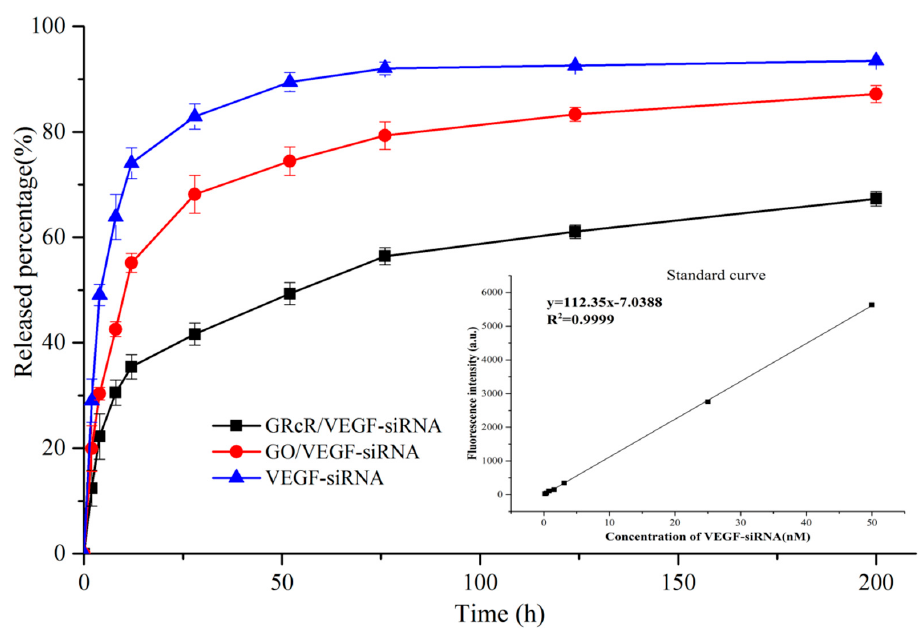
Figure 9. Release profile of VEGF-siRNA from GO (red) and GRcR (black). The data was presented as the mean ± SD, n = 3.